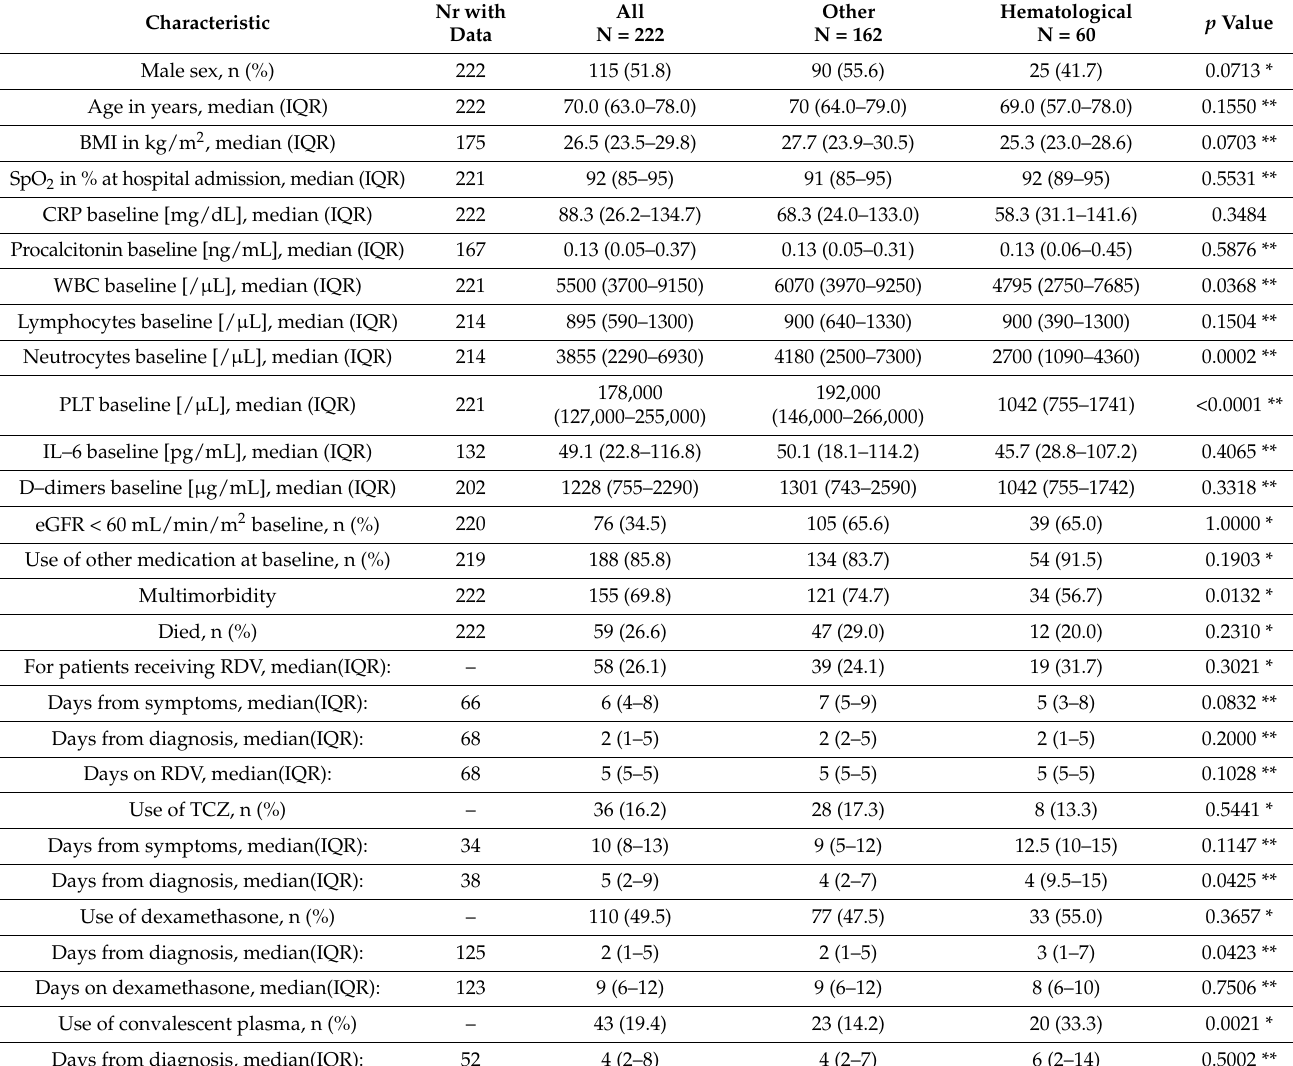
Table 2. Baseline characteristics of studied cohort stratified by the type of